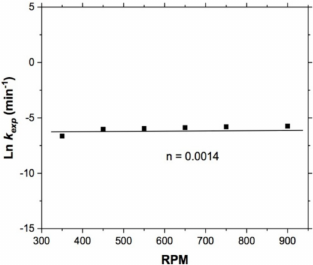
(cid:104) (cid:105) S 2 O − 2 = 0.5 mol/L, 750 RPM, pH = 10, and 5 g of sample. 3